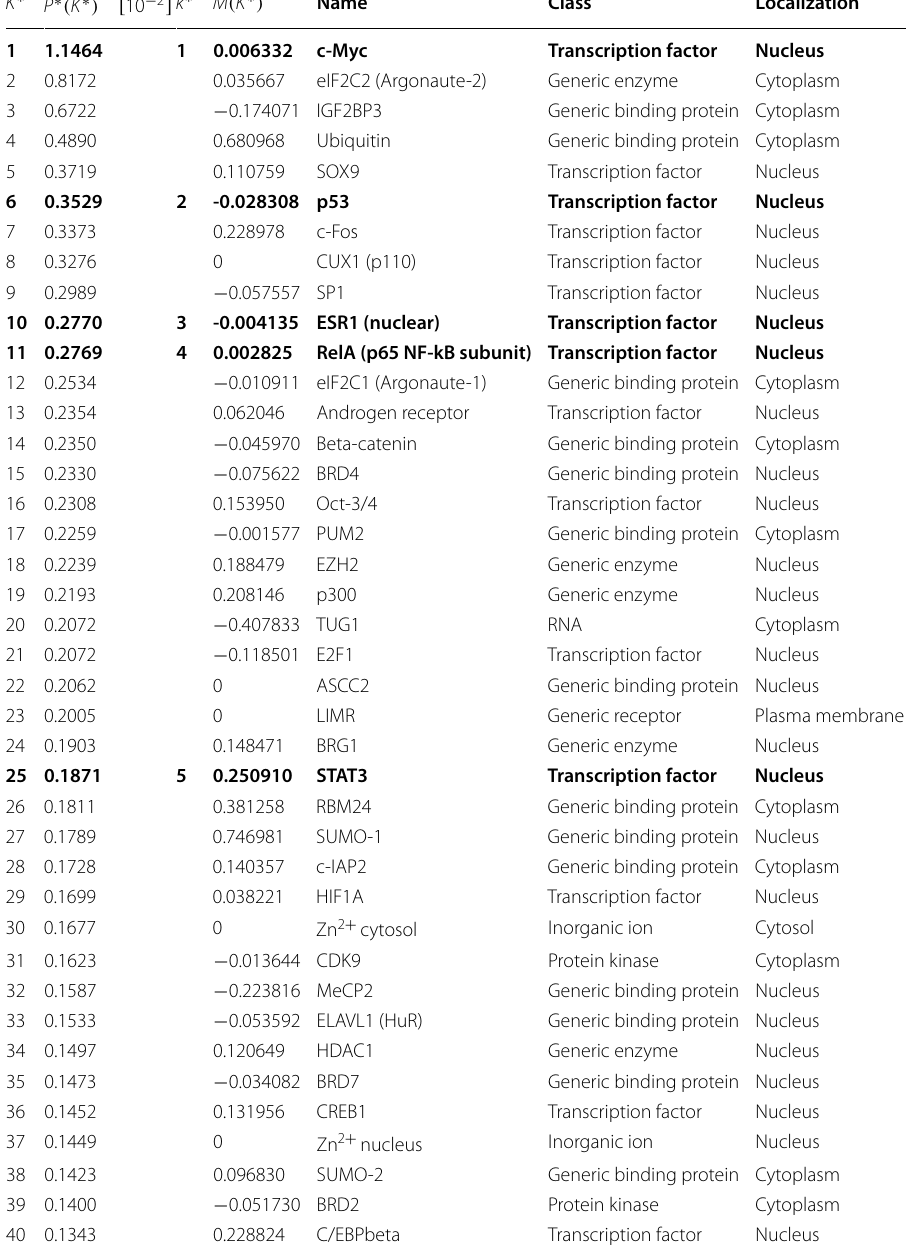
Table 2 Top 40 CheiRank nodes of the simple MetaCore